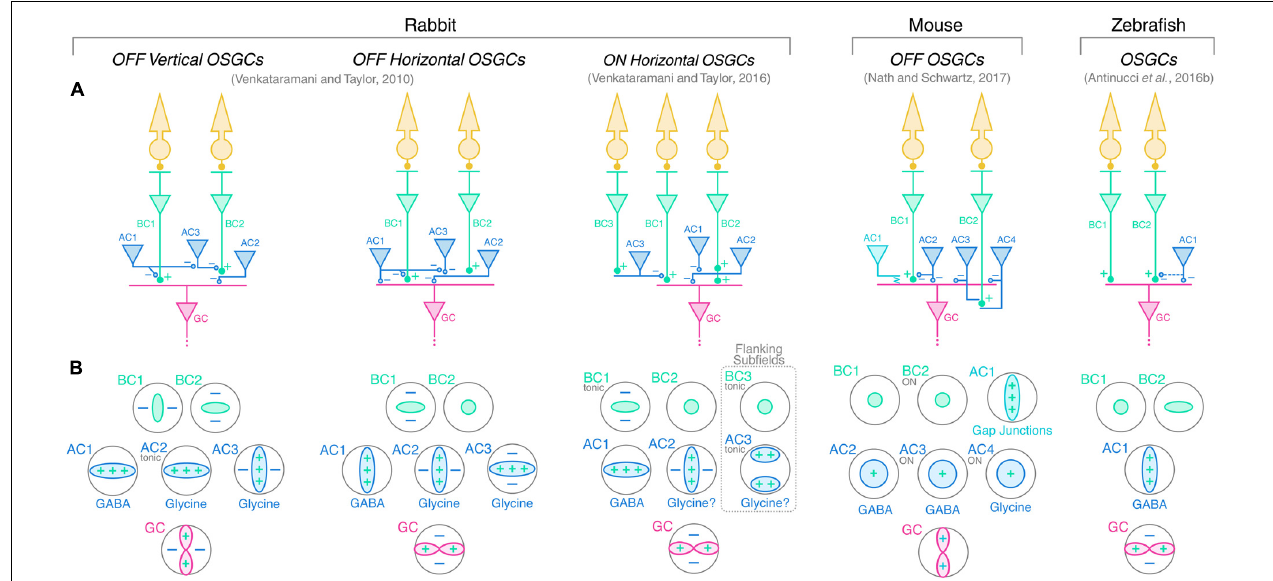
FIGURE 5 | Working models of orientation-selective retinal circuits in vertebrate retinae. (A) Proposed circuit diagrams underlying the firing selectivity of different OSGC types in rabbit (left), mouse (middle), and zebrafish (right). Photoreceptors are represented in yellow; bipolar cells (BCs) in green; amacrine cells (ACs) in blue; and ganglion cells (GCs) in red. Cell numbering is used to relate each cell type with the corresponding tuning profile shown in (B) below. Excitatory synapses are indicated by ‘+’ symbols (full circles), whereas inhibitory synapses are indicated by ‘–’ (empty circles). Electrical synapses between mouse OFF orientation-selective amacrine cells (AC1) and OFF OSGCs are indicated by the jagged line. Potential but speculative connectivity between AC1 and BC terminals in larval zebrafish is represented by the dashed blue line. (B) Response profiles of the cell types represented in A to oriented visual stimuli. ‘+’ and ‘–’ symbols indicate along which axes excitatory (+, green) and inhibitory (–, blue) inputs contribute to the tuning of each cell type. The neurotransmitter identities of the various amacrine cell types are also reported (question marks indicate predicted neurotransmitter identities). GABA, gamma-aminobutyric acid. Tonic inputs are specified in small gray writings. Unless specifically indicated in small gray writings, the response polarity of the various cell types is the same as that of the respective downstream OSGC. In rabbit and zebrafish circuits, orientation selectivity is proposed to originate from orientation-selective GABAergic amacrine cells (AC1), which subsequently generate tuned responses in downstream amacrine, bipolar and/or ganglion cells through inhibitory synapses. In the mouse OFF circuit, AC1 amacrine cells convey orientation selectivity to OFF OSGCs by electrical coupling through gap junctions. Rabbit ON horizontal OSGCs possess two horizontally oriented flanking subfields generated by tonically active amacrine cells (AC3), which are predicted to invert the ON pathway signal by disinhibiting center bipolar cells (BC1) and, therefore, render negative contrast stimuli in the flanking subfields excitatory (dashed box).